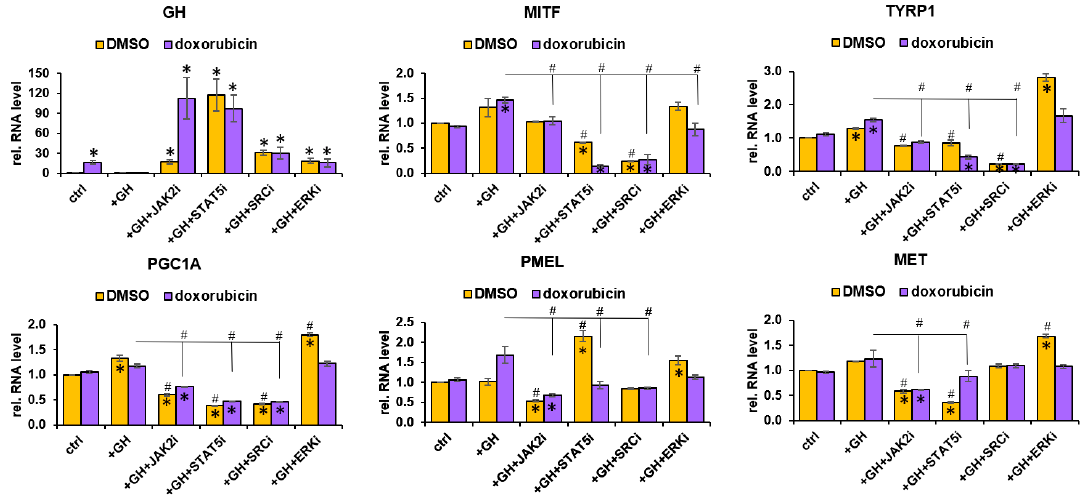
Figure 8. GH-regulated MITF and MITF target gene regulation proceeds via JAK2–STAT5- and SRC- regulated pathways: Human melanoma cell MDA-MB-435 (here), SK-MEL-28 (supplementary Figure S9) and SK-MEL-30 (supplementary Figure S10) were treated with/without doxorubicin in the presence of GH as well as different intracellular signaling pathway inhibitors. After 24 h treatment, RNA expression for target genes (GH, MITF, and MITF targets) was quantified by RT-qPCR and normalized against expression of TUBB5 and ACTB as reference genes (#,*, p < 0.05, Wilcoxon sign rank test, n = 3; * indicates comparison against corresponding -GH controls while # indicates comparison against corresponding +GH controls in DMSO and doxorubicin treated groups).